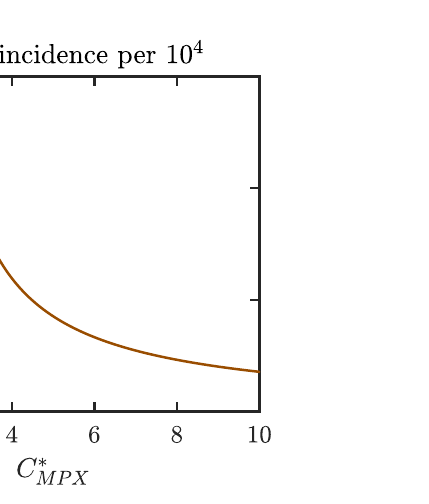
is the only NE NE